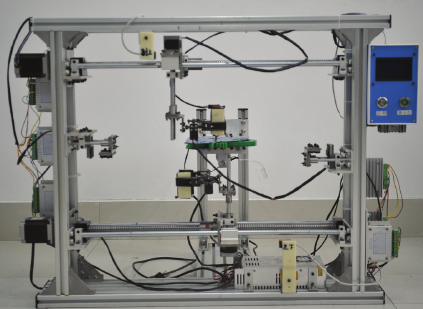
Figure 14: The developed sapling grafting robot.